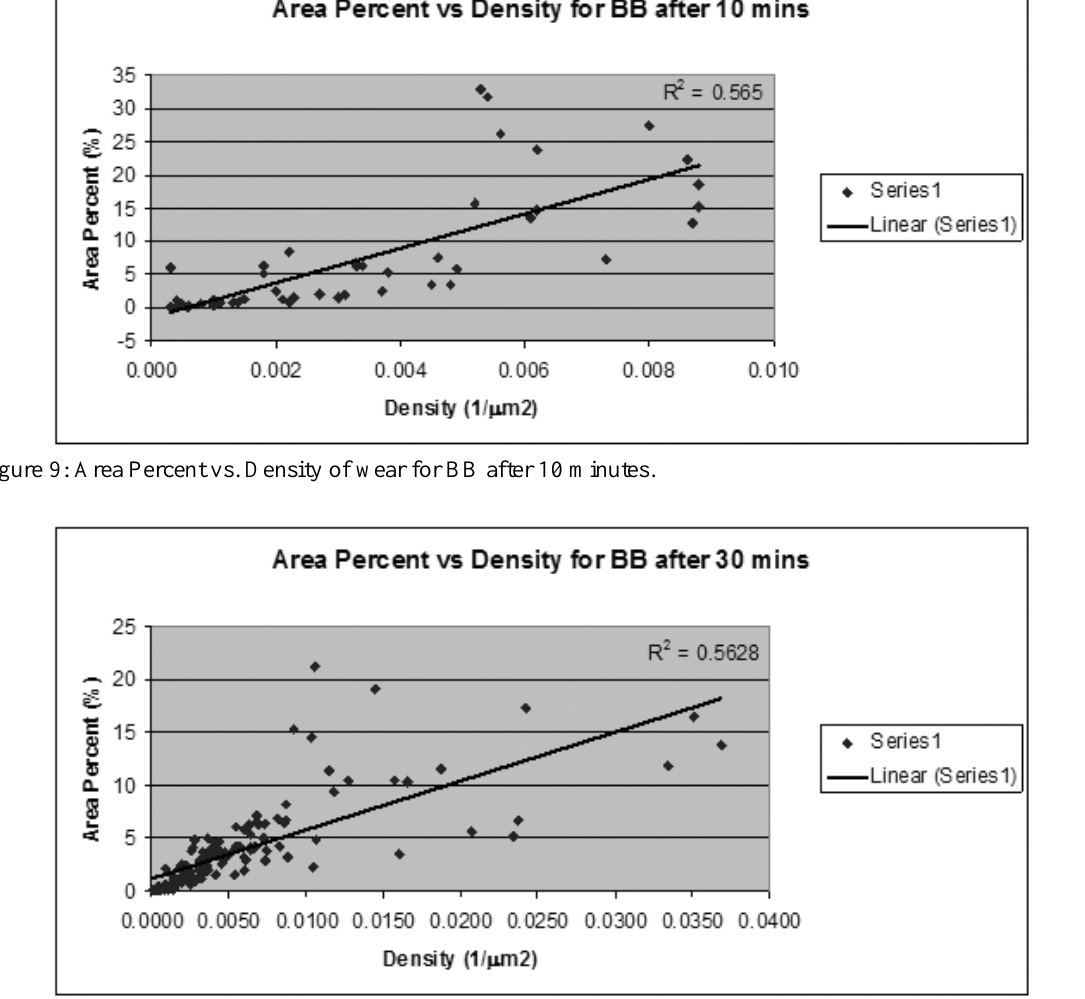
Figure 10: Area Percent vs. Density of wear for BB after 30